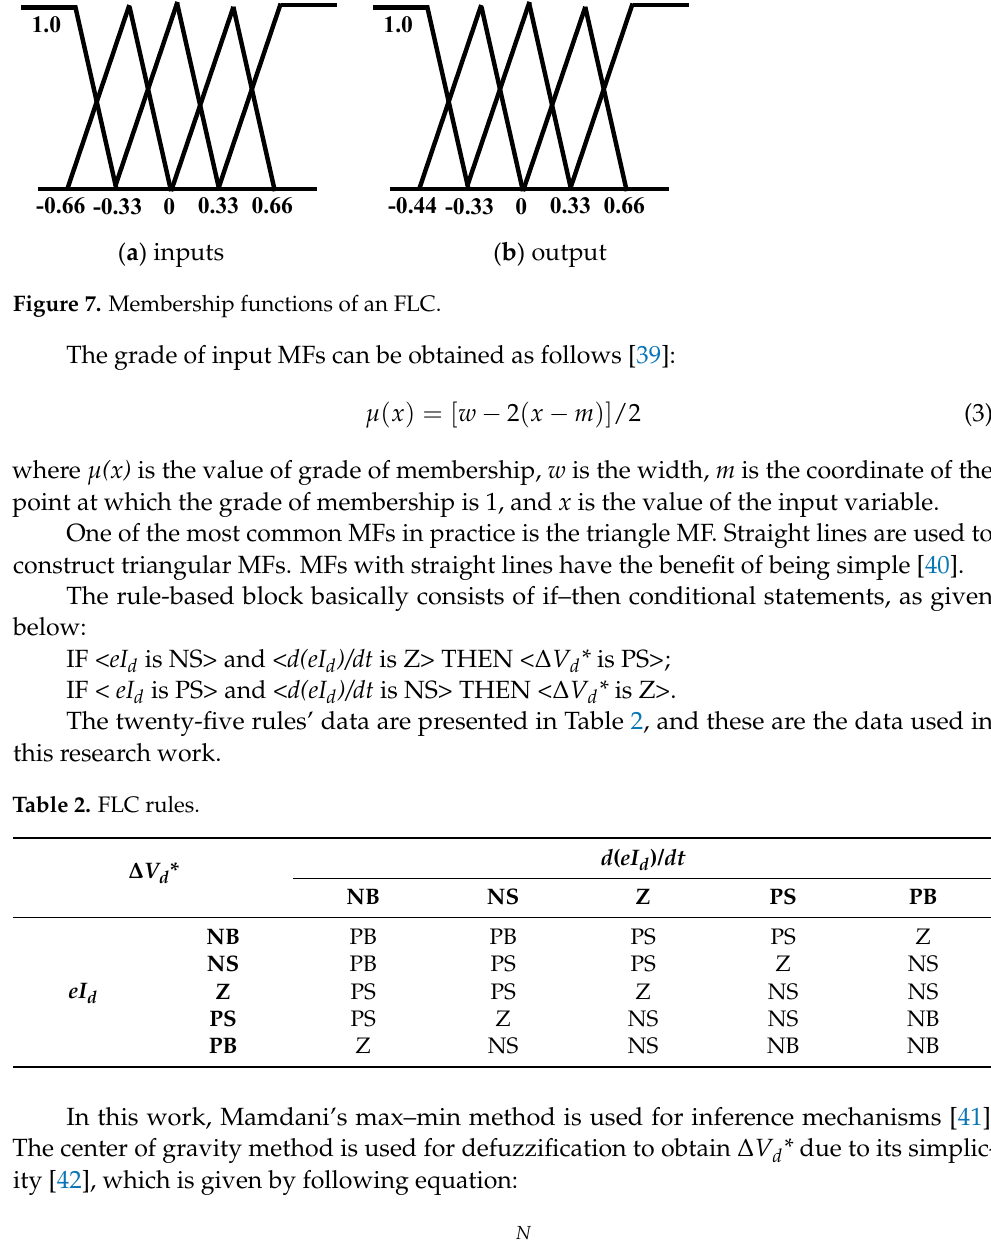
7 of 15 Figure 6. Structure of the proposed FLC.